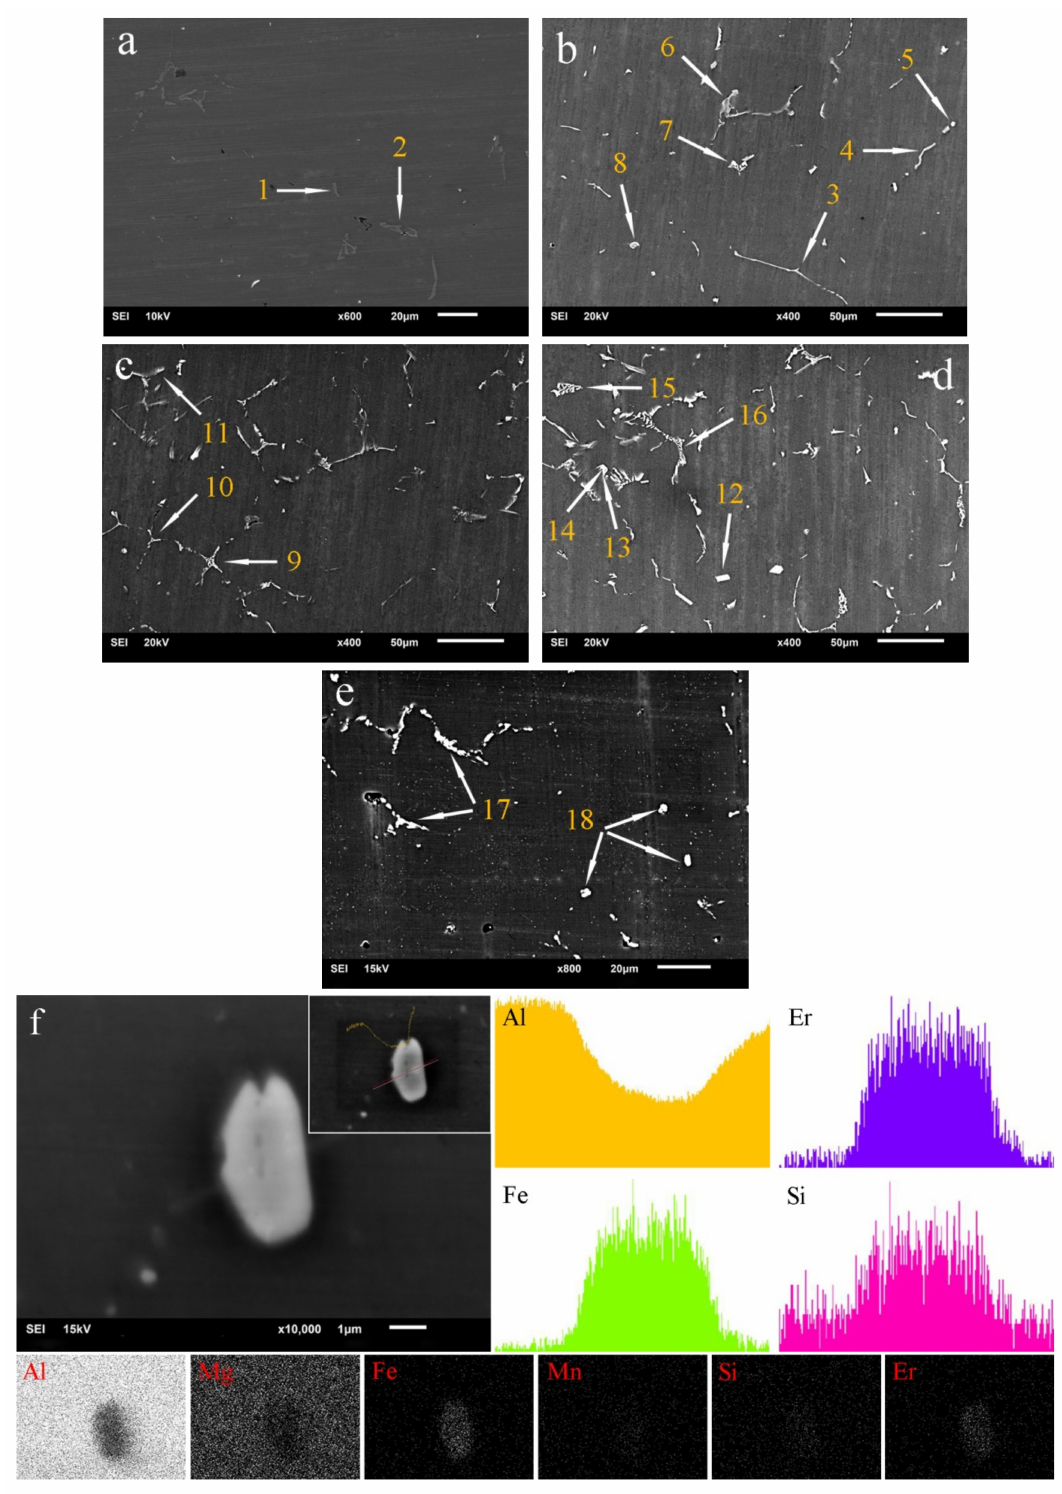
Figure 5. Microstructure of 5052 aluminum alloys observed via SEM: as-cast ( a ) A0 without Er, ( b ) A2 with 0.2% Er, ( c ) A3 with 0.4% Er, ( d ) A4 with 0.8% Er; homogenized ( e ) A3 with 0.4% Er and ( f ) a dot phase analyzed via EDS line scanning and surface